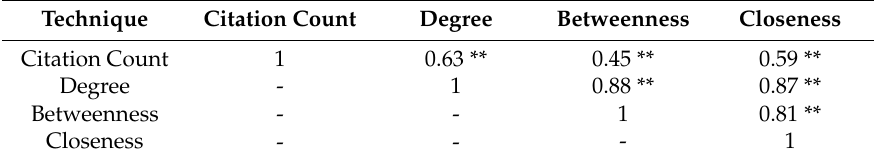
Table 10. Spearman correlation between degree, betweenness, closeness and citation count.